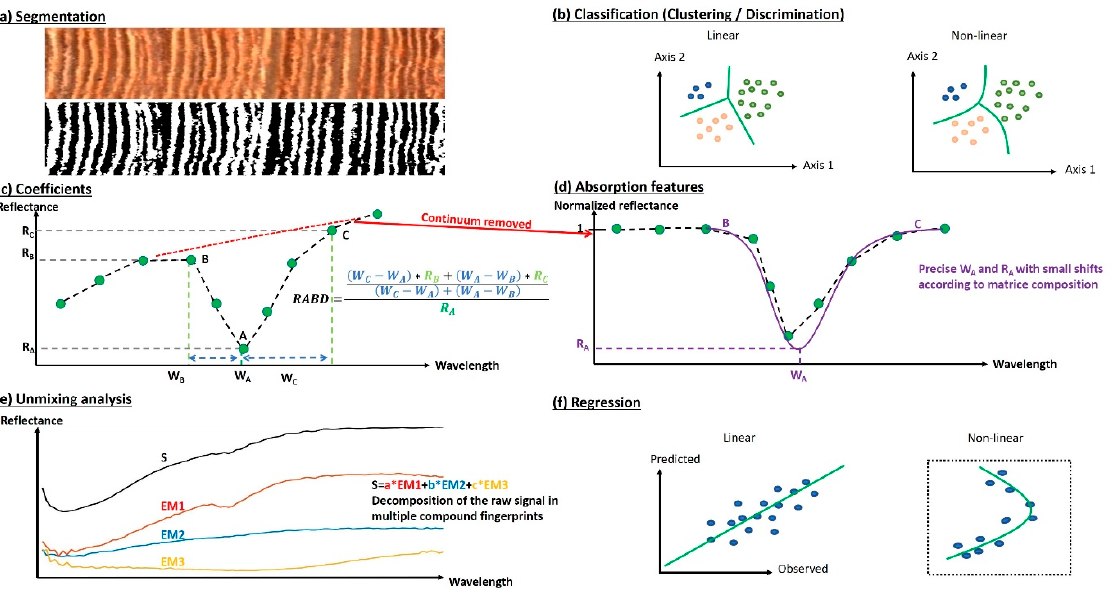
Figure 9. Representation of the seven principal groups of processing methods. ( a ) Segmentation approach on the spatial dimension. ( b ) Classification approaches (clustering and discrimination) with the comparison of linear and nonlinear approaches. ( c ) The coefficient methodology is followed by continuum removal spectral processing to estimate a value. ( d ) The absorption features with signal modeling. ( e ) Unmixing analysis with decomposition into pure signals called endmembers (EM). ( f ) Regression approaches with the comparison of linear and nonlinear approaches.